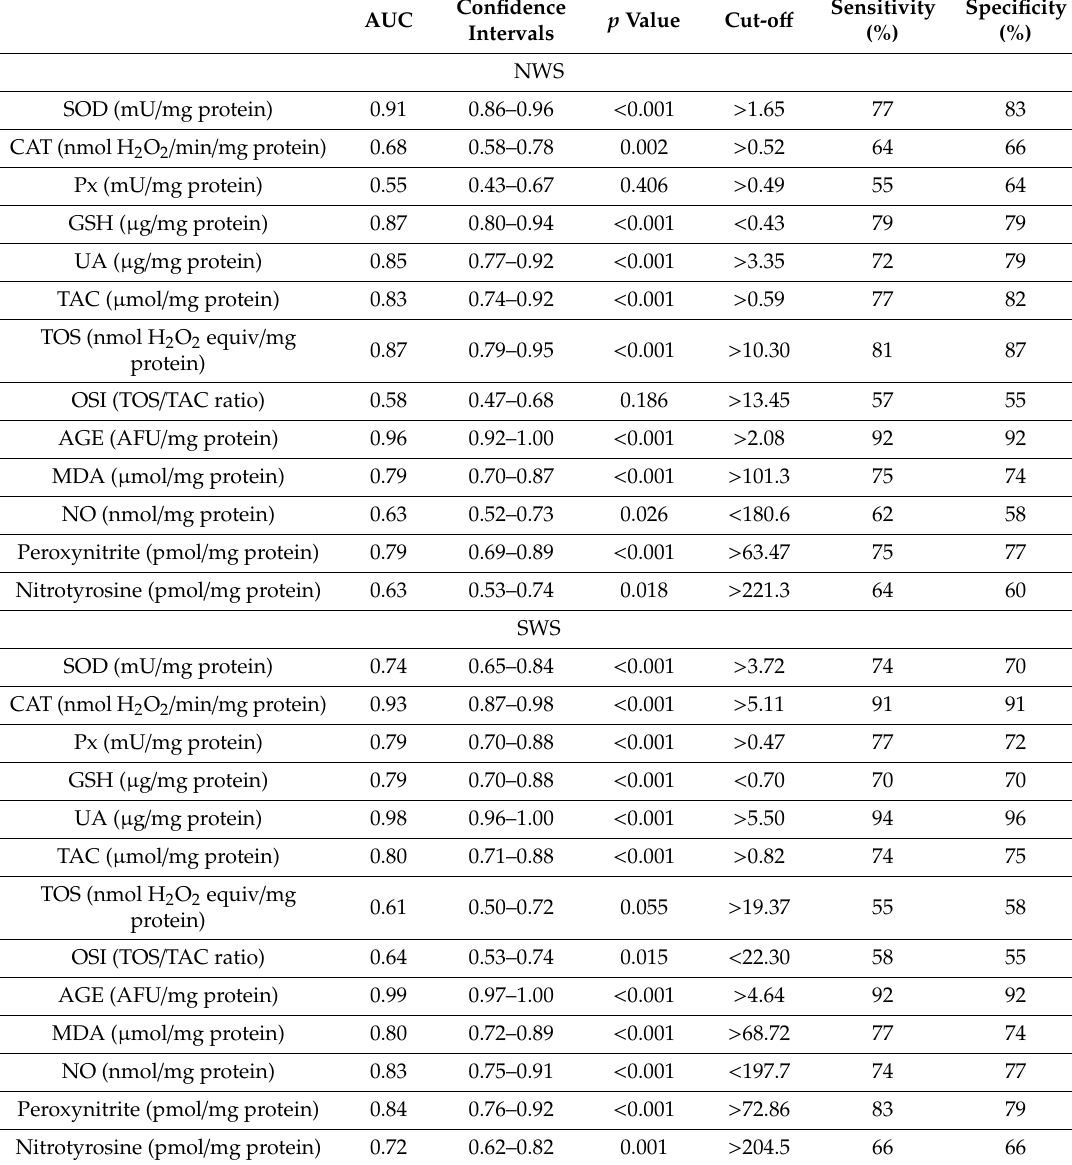
Table 6. Receiver operating characteristic (ROC) analysis of redox biomarkers in non-stimulated and stimulated saliva of children with hypertension and the control